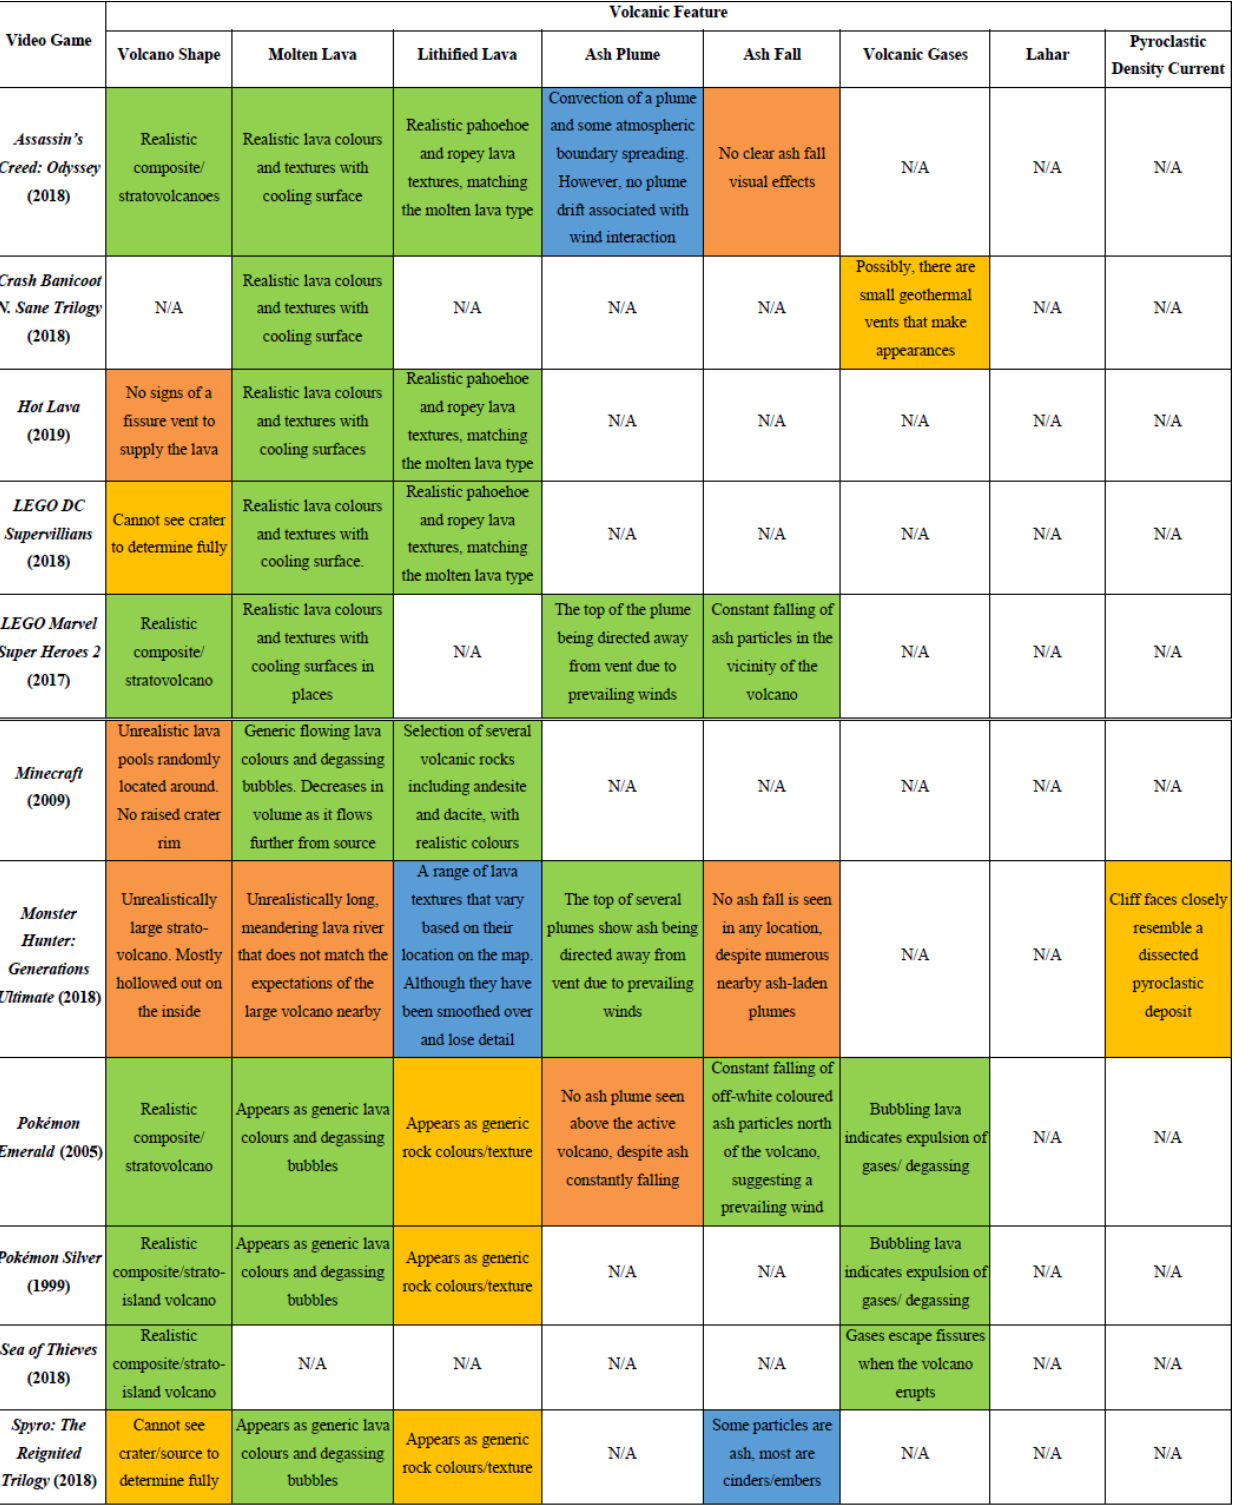
Table 1. A summary of volcanic features in individual COTS video games. Features are colour-coded based on if they are realistic (green), unrealistic (orange), or both realistic and unrealistic (blue) and if there was insufficient data to determine accuracy (yellow) or not applicable due to no examples (N/A;